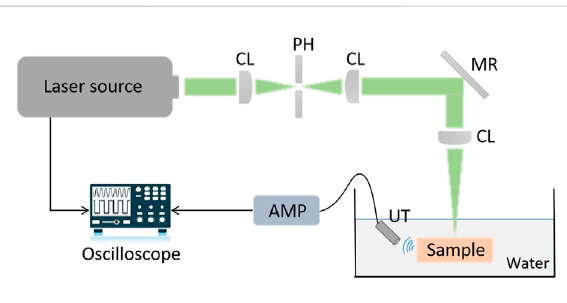
FIGURE 6 Signal acquisition and characterization of cancellous bone andcorticalbonebased onasingle element